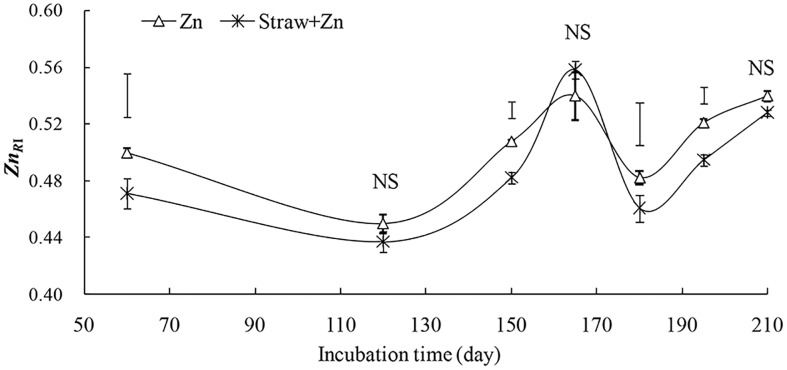
The relative amount of ineffective Zn (ZnRI) in soils with the water-soluble Zn application (Zn) alone and along with straw (Straw+Zn) at the various incubation periods.The bars on the curves are standard errors (n = 3) and the bars above the curves represent the least significant difference (LSD) at 5%.